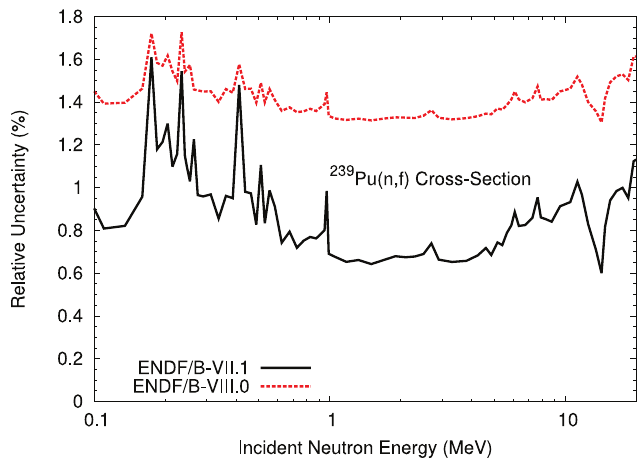
Fig. 1. The ENDF/B-VII.1 239 Pu(n,f) cross-section uncertain- ties (previous NDS) are compared to those of ENDF/B-VIII.0 (current